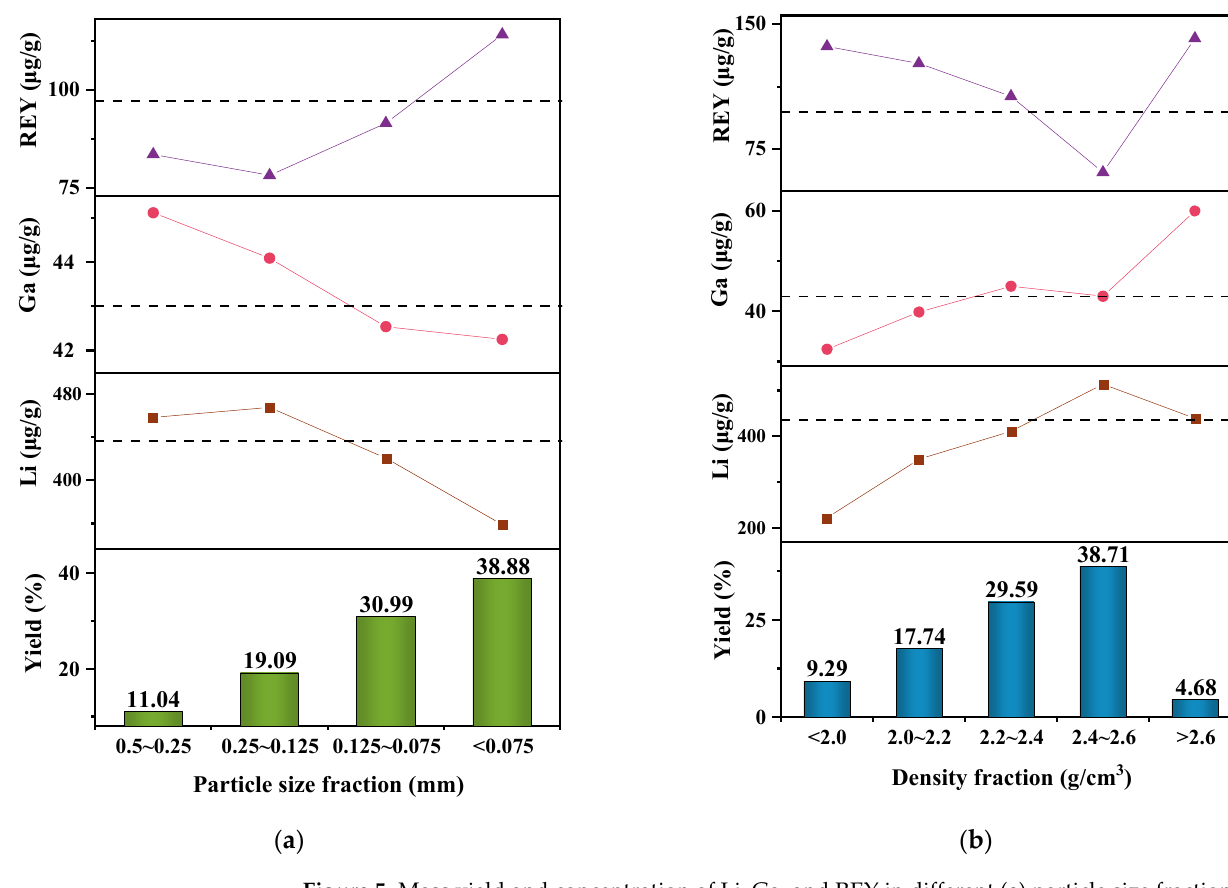
Figure 5. Mass yield and concentration of Li, Ga, and REY in different ( a ) particle size fractions and ( b ) density fractions.